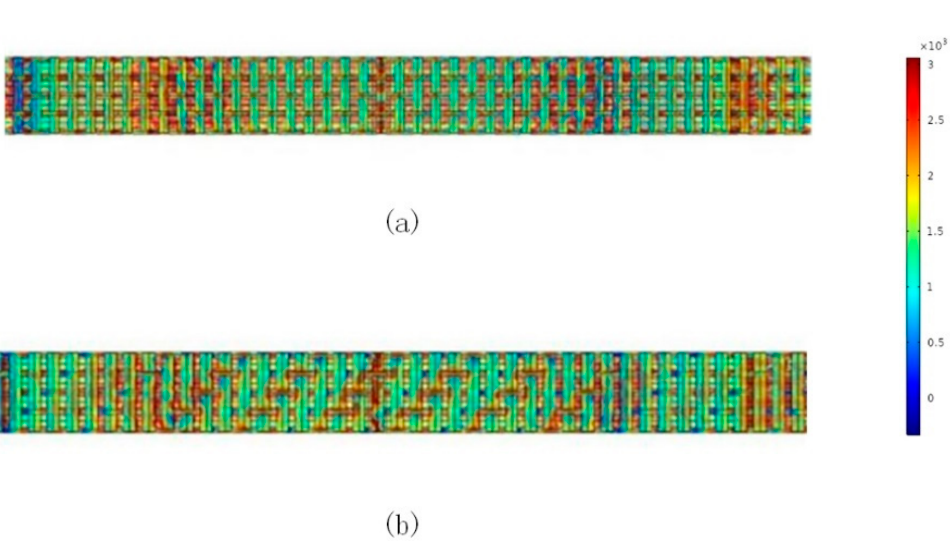
Figure 5. When the same load of 500 N is applied, the component distribution diagram of the prin ‐ cipal stress in the z ‐ axis direction (MPa): ( a ) the top view of the PTW structure, and ( b ) the top view of the TTW structure.